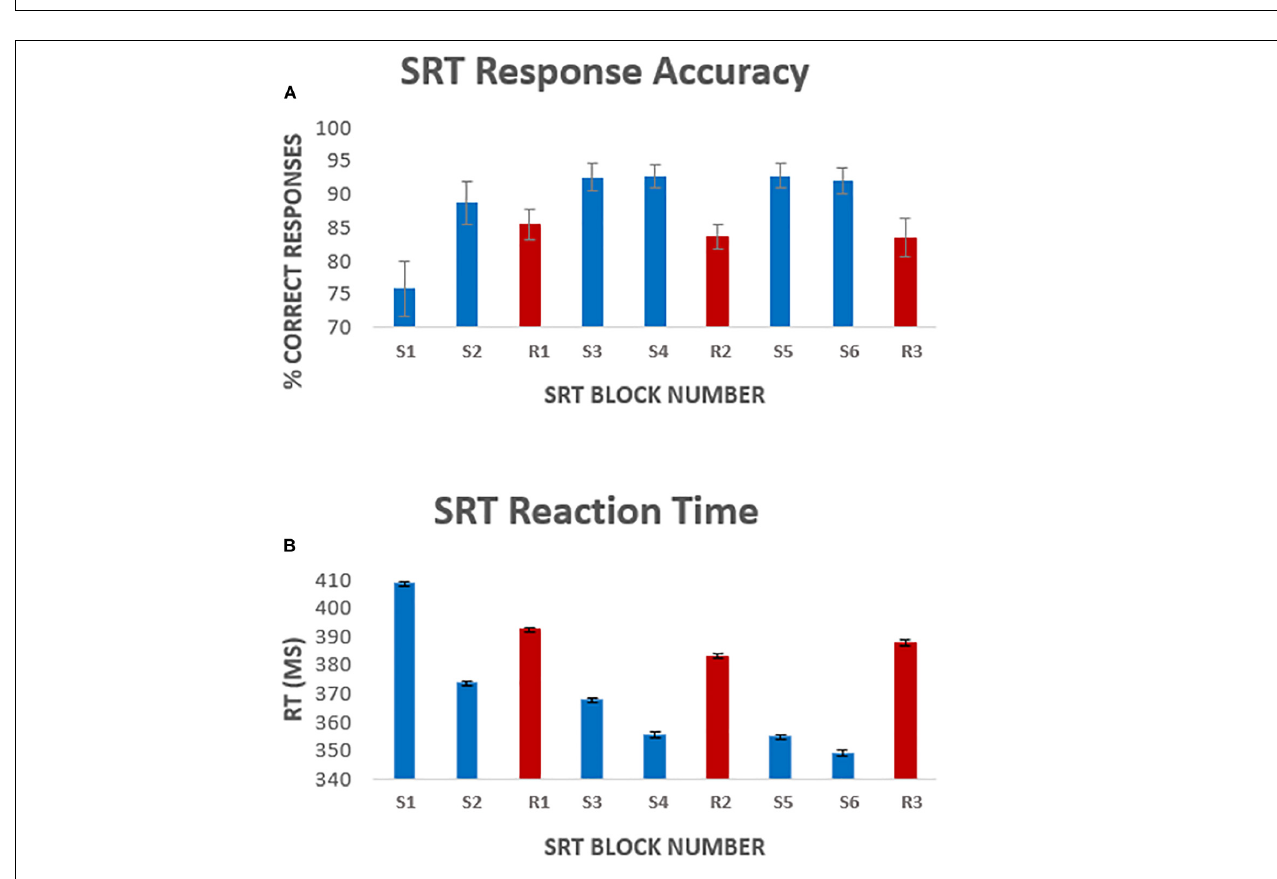
FIGURE 2 | Average [mean ± standard error of the mean (SEM)] response accuracy per block (A) , and average response latency (B) per task block. Error bars represent the standard error of the mean across participants. Blocks S1–S6 represent the 6 sequence blocks, responses to these blocks were the focus of the analysis. Blocks R1, R2, and R3 (shown in red) represent pseudorandom sequence